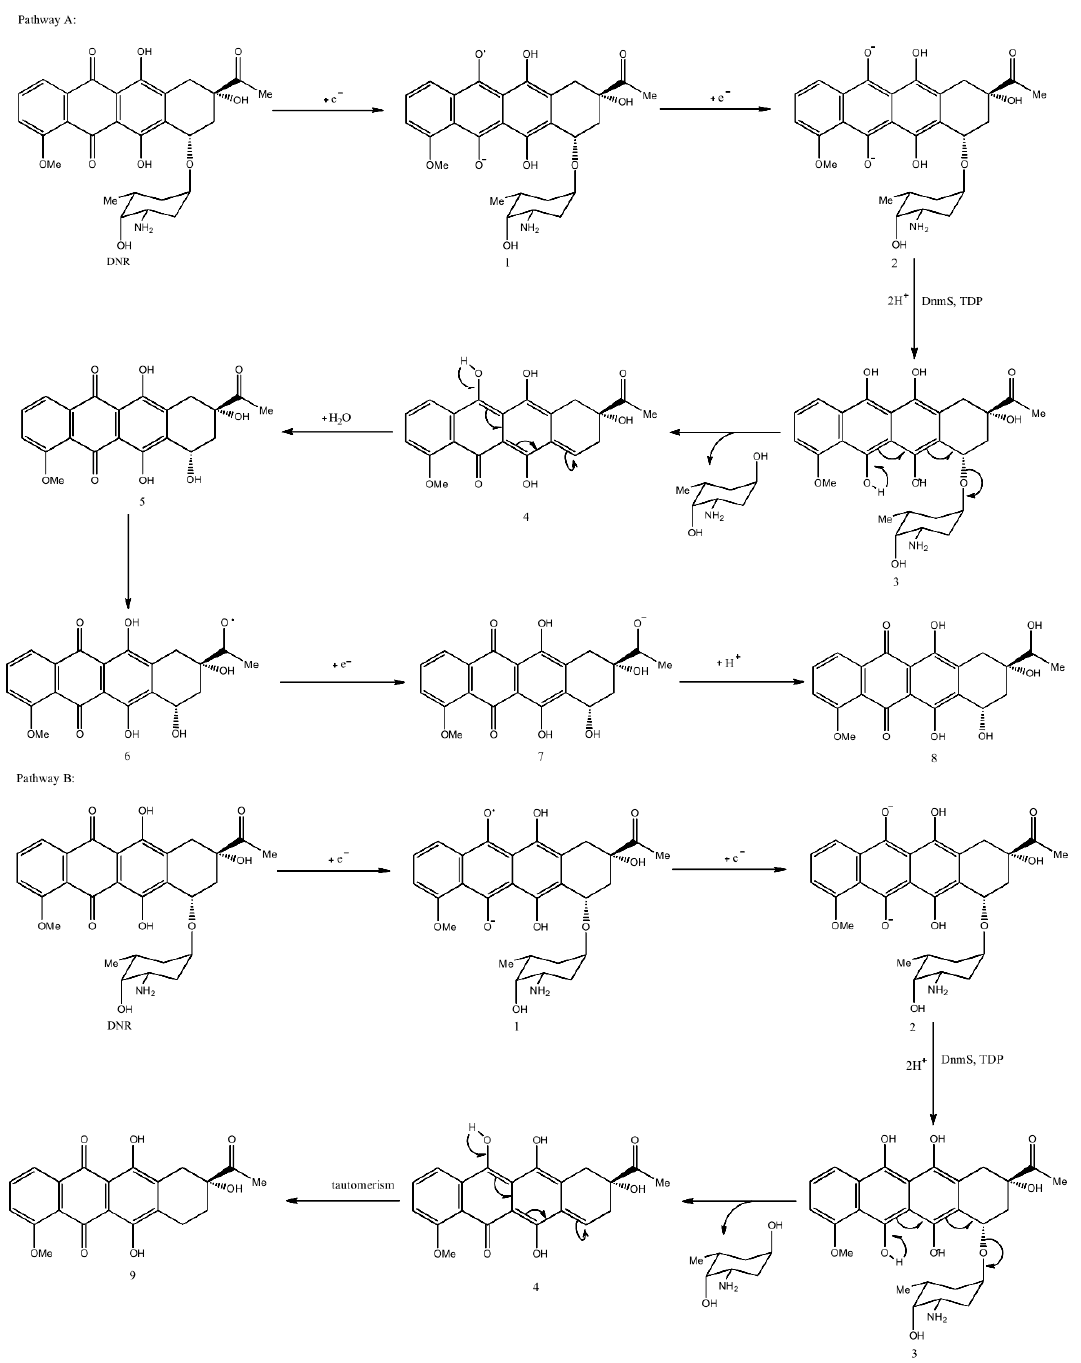
Figure 4. Pathway A and B show DnmS catalyzed reverse glycosyltransfer reactions and possible electron and free radical transfer during the reaction. Pathway A: DNR receives two electrons to obtain divalent anion intermediate 2. Then, under the action of DnmS and TDP, the next two protons coordinated with 2 produce intermediate 3, which is transferred to intermediate 4 through a series of double bonds. Intermediate 4 is attacked by water molecules to obtain intermediate 5, and the carbonyl group of the ketone part of 5 is attacked by hydrogen free radicals to form intermediate 6. Finally, intermediate 6 receives an electron and a proton to obtain product 8. Pathway B: DNR receives two electrons and gives the dianion intermediate 2. Then, under the action of DnmS and 4 via a series of double bond migrations. Tautomerism of 4 generates product 9 with a 1,7 ‐ H migra ‐ tion.